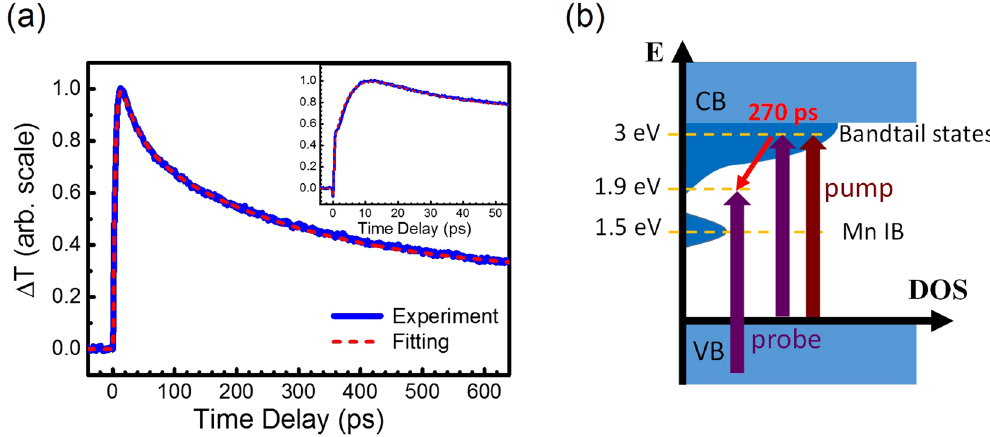
Figure 6. ( a ) The transient transmission changes of the probe pulses through Mn-doped GaN with concentrations of 1.2 × 10 20 cm − 3 . The pump/probe photon energy is 3 eV (410 nm). ( b ) The schematic diagram illustrates the carrier dynamics in the bandtail states monitored by the 3 eV probe